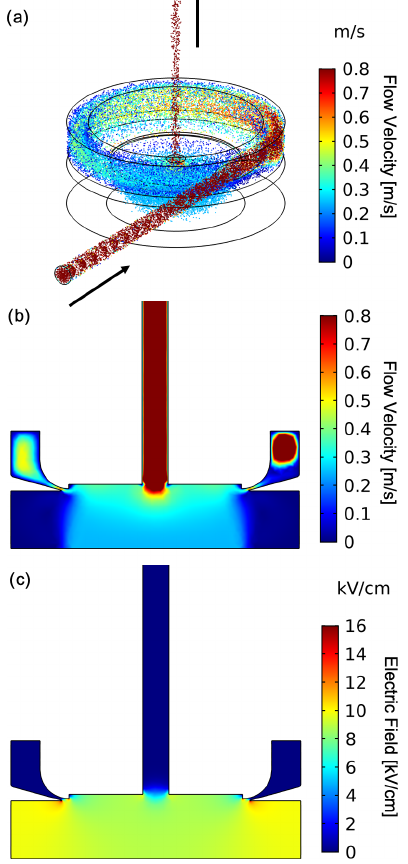
Figure 2. Example of finite-element simulations of the scanning ROMIAC at an aerosol flow rate of Q a = 1 . 2Lmin − 1 and a cross- flow rate of Q c = 12Lmin − 1 , with particle diameter of d p = 4 . 0nm. (a) Particle trajectories over a 50s upscan at t ≈ 25s. Cross- sectional view of (b) the flow velocity and (c) electric field distri- bution. The magnitude of the electric field corresponds to the max- imum, 10kV, electric potential. Particles enter the ROMIAC from the entrance slit that is tangential to the classification region and leave the ROMIAC from the slit perpendicular to the classification